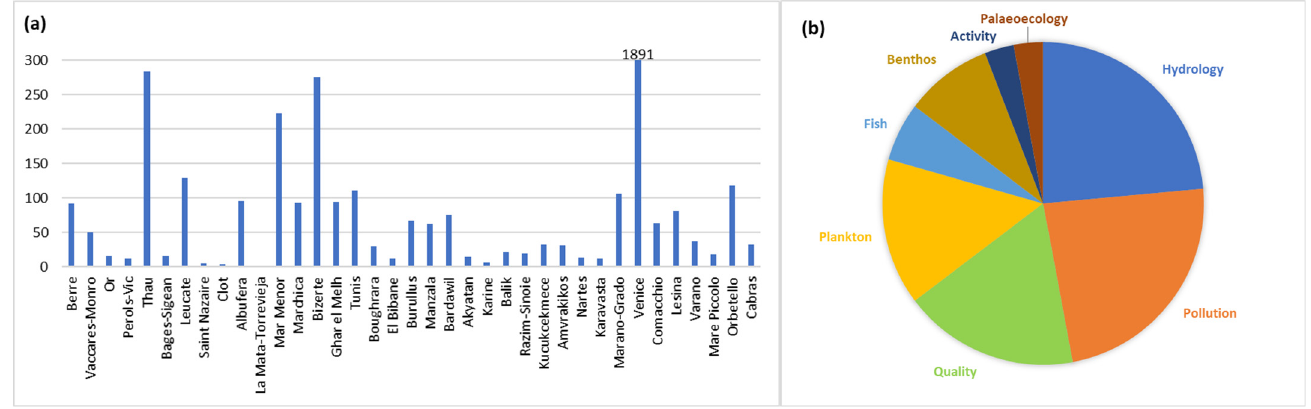
Figure 4. ( a ) Number of scientific publications indexed on each of the Mediterranean coastal lagoons. ( b ) Scope of the recent papers from 2016 to 2021 published in each lagoon.